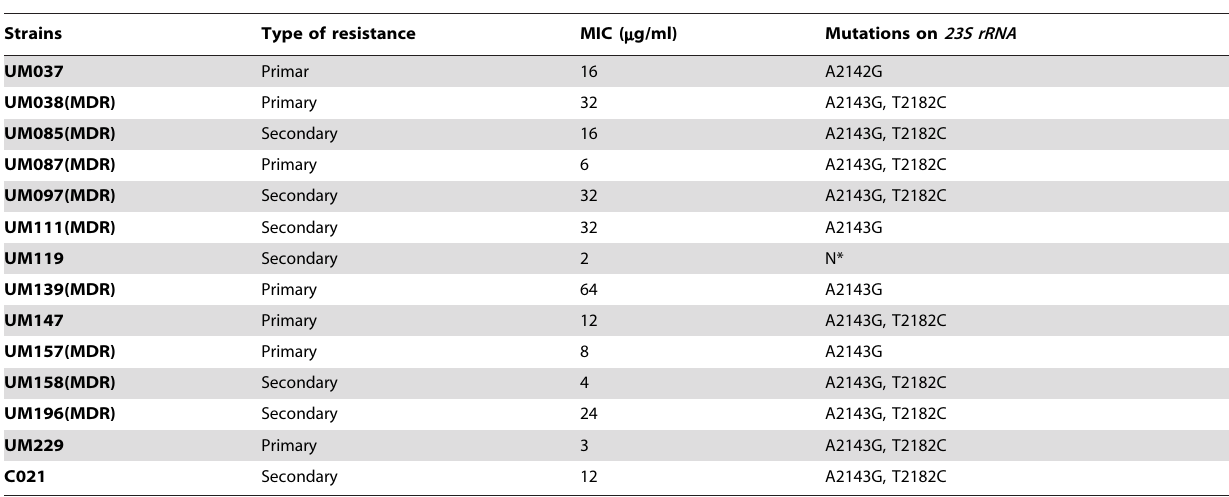
Table 5. MIC of clarithromycin and 23S rRNA mutations.